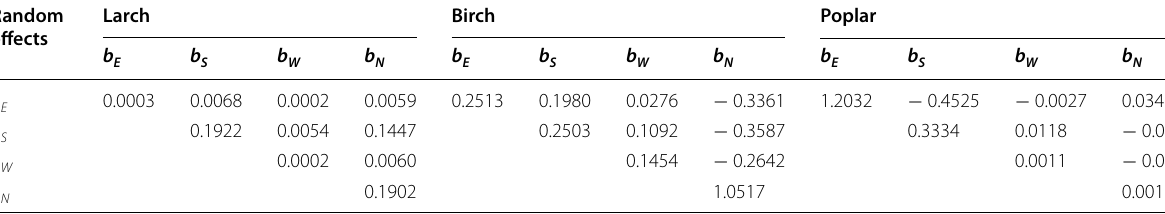
Table 5 Random effects variance-covariance matrix of NSURMEM systems Random effects